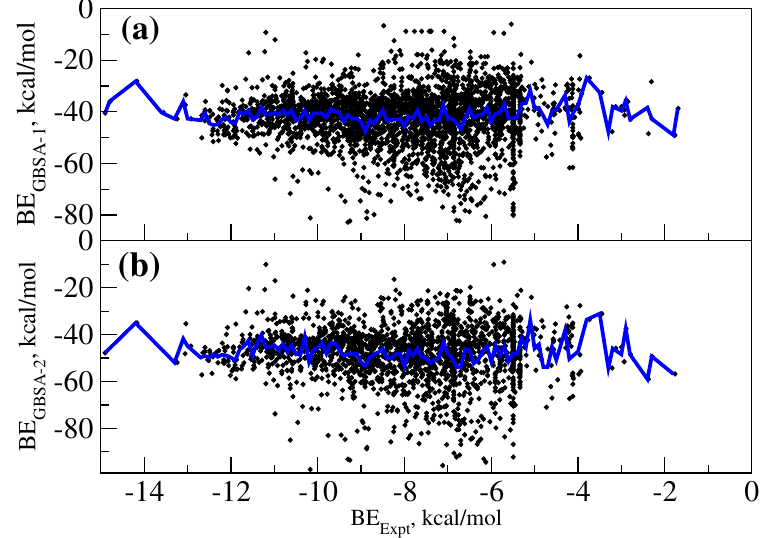
Figure 4. ( a ) Comparing the experimental binding free energies and MM-GBSA-based predicted free energies for various MAO-B ligand complexes. ( b ) Comparing the experimental and autodock-based predicted binding free energies. The black spots represent different data points of the scatter diagram of experimental and predicted binding free energies. The plot in blue color shows F(BE expt ) as a function of experimental binding free